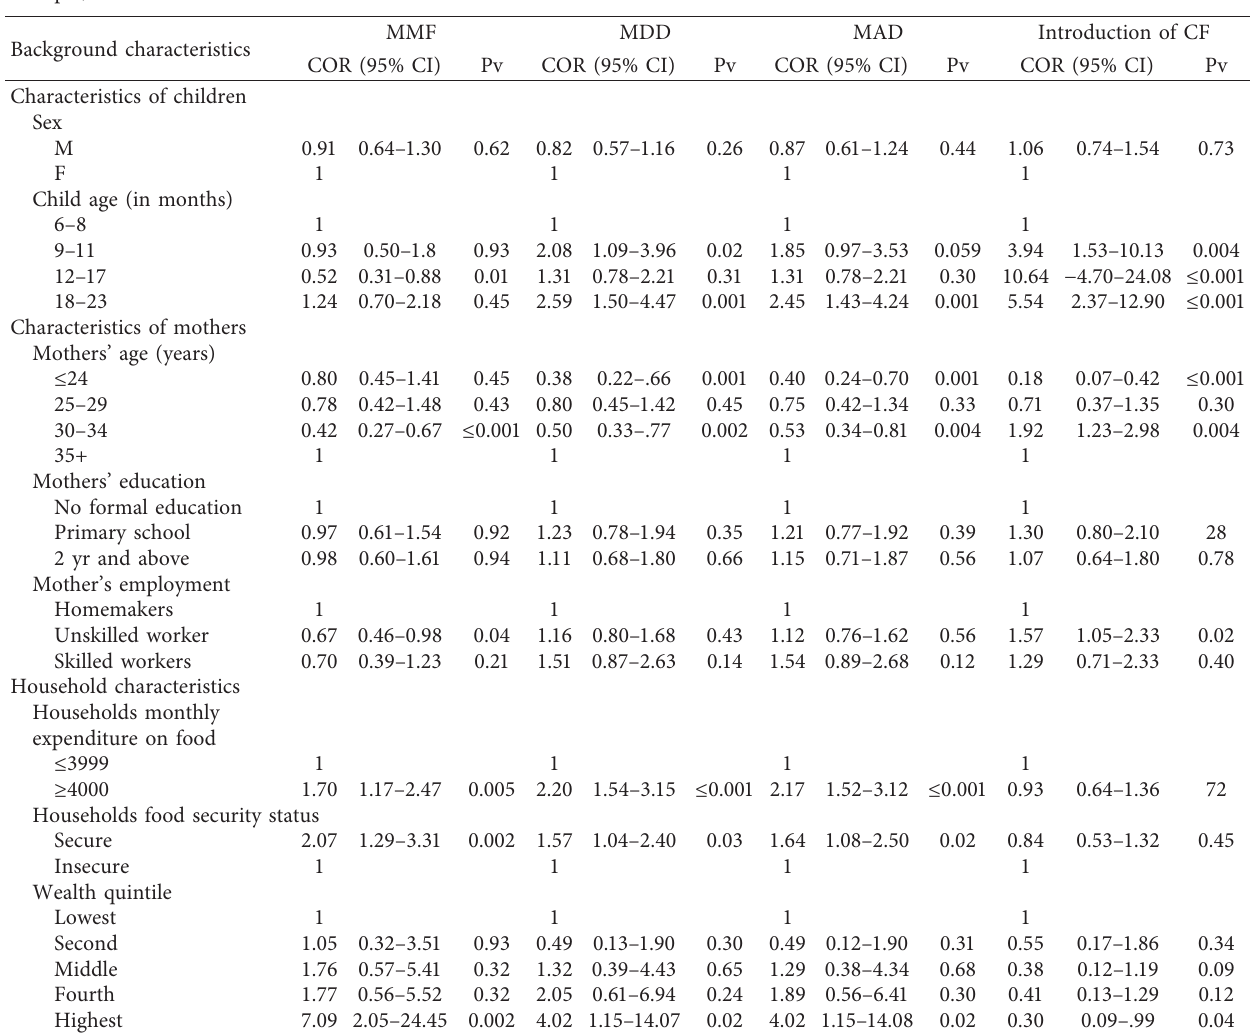
Table 5: Bivariate association of food security status with CF indicators of children aged 6–23months old in Shashemene city, Oromia, Ethiopia, 2020. Background